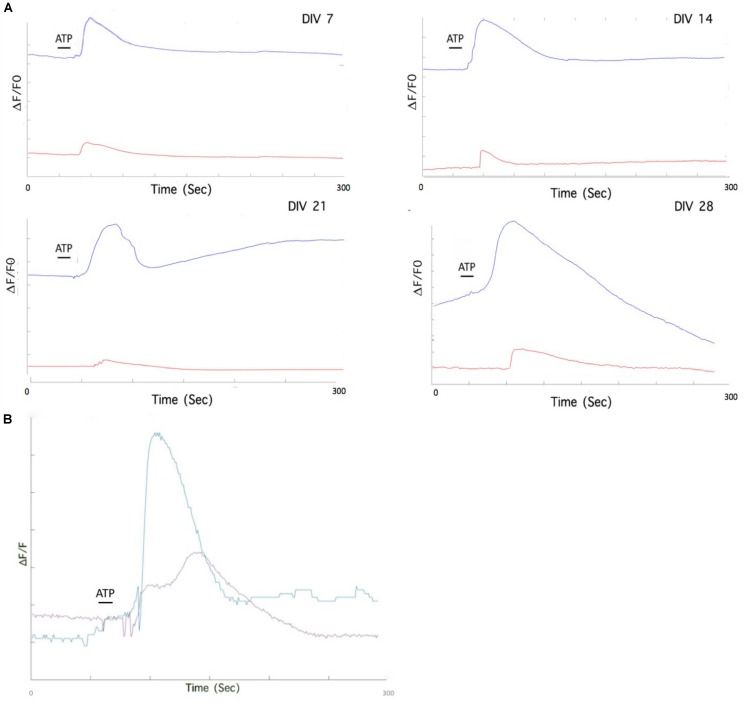
Pharmacological treatment of mESC derived astrocytes isolates individual purinoceptor contributions to Ca2+ elevation. (A) Individual astrocytes from MRS2179 treated DIV 7-DIV 28 cultures exhibit stunted Ca2+ responses after ATP application (red traces), compared to untreated astrocytes (blue traces). (B) Pharmacological treatment of mESC derived astrocytes with phospholipase C (PLC) inhibitor, U73122. Bath incubation of DIV 28 astrocytes with U73122 results in a stunted response upon ATP stimulation. Purple trace. ATP response after U73122 treatment; Blue trace, ATP response without U73122 treatment.